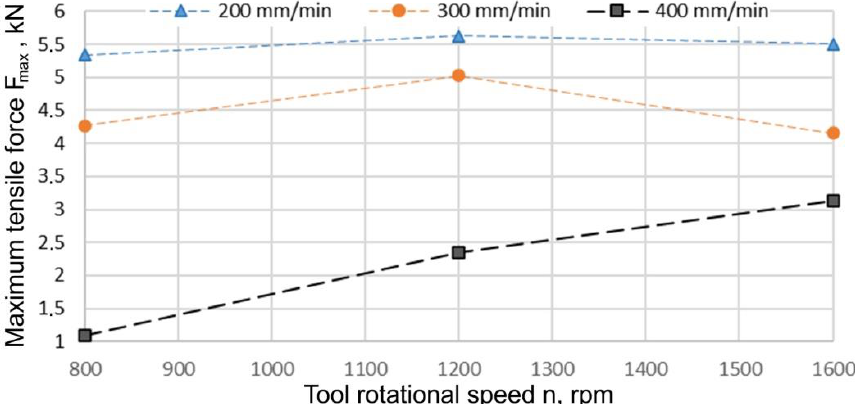
Figure 14. Effect of the tool rotational speed and welding speed on the maximum force transmitted by the joint F max (x 1 = 1.5 mm).